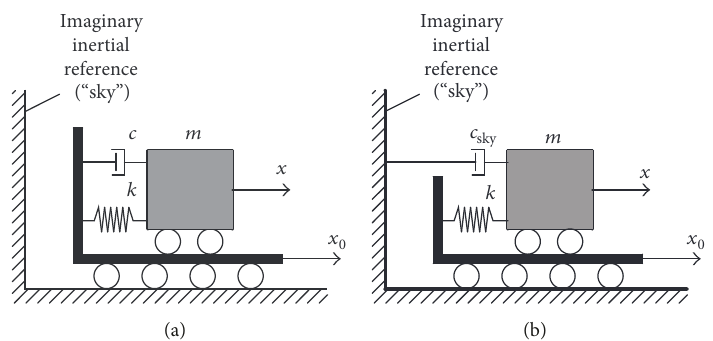
Figure 7: Conventional (a) and ideal sky-hook (b) damping schemes for a single degree of freedom system.